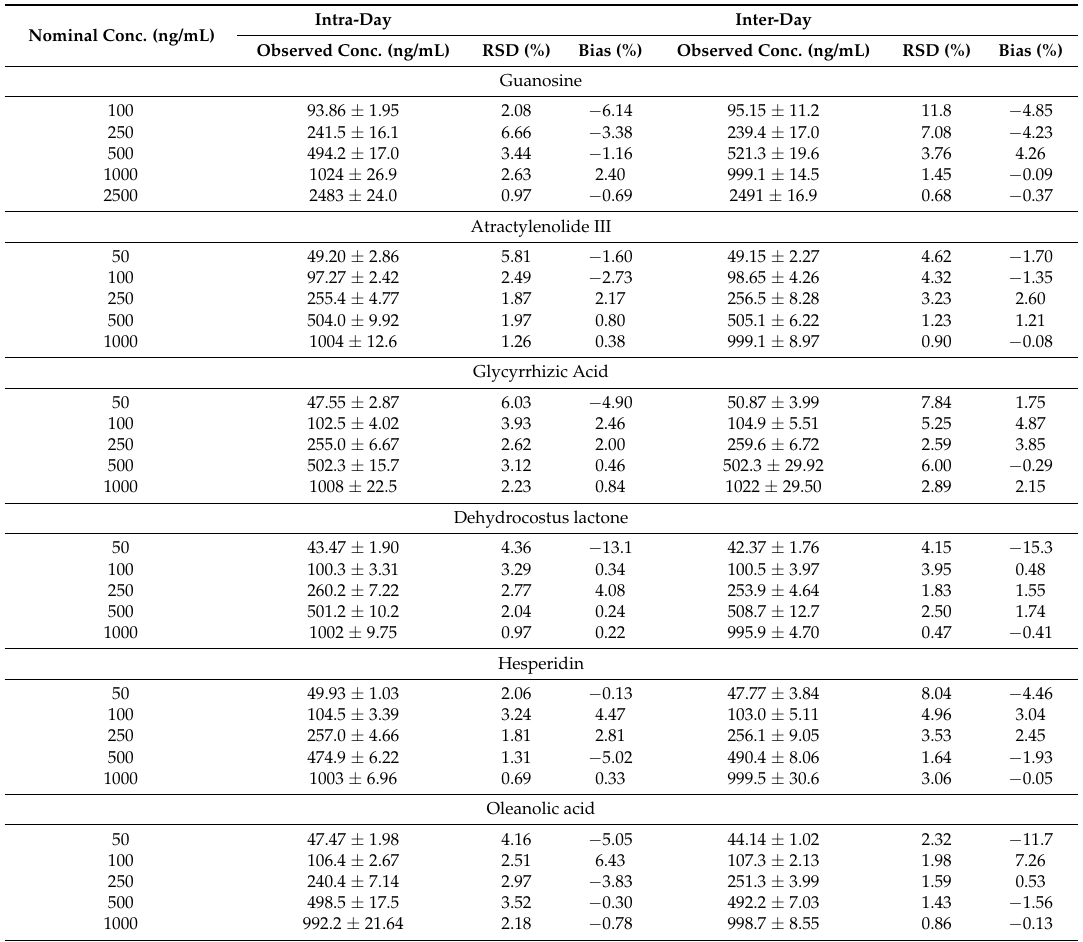
Intra-day and inter-day precision and accuracy for the six active components